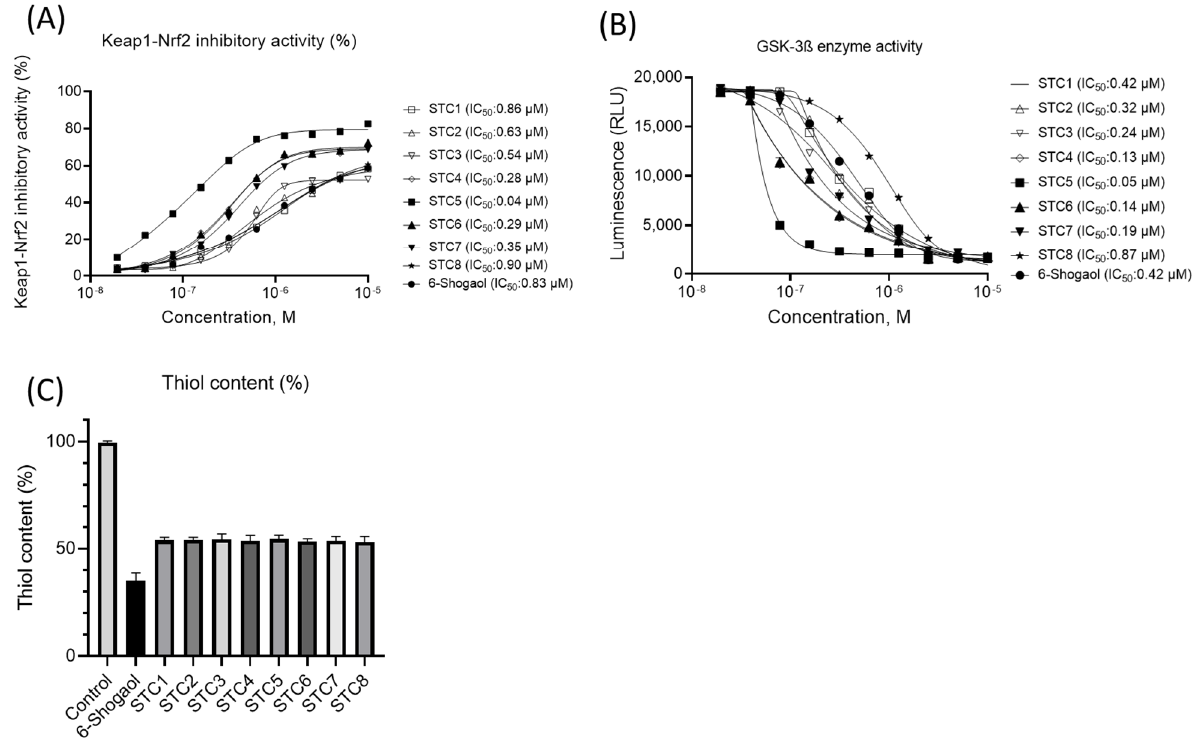
Figure 6. The different modes of NRF2 activation exerted by 6 − shogaol and STCs were determined via ( A ) KEAP1 − NRF2 inhibition, ( B ) GSK-3 β enzyme activity, and ( C ) interaction with thiols of cysteine by measuring the free thiol content are shown.